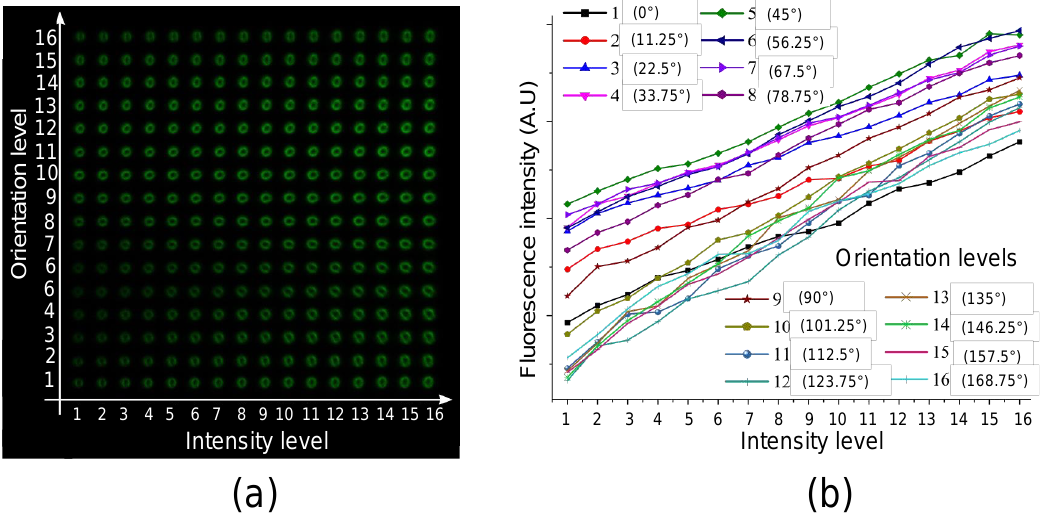
Figure 2. Fabricated fluorescence calibration matrix. ( a ) Confocal image of all basic storage units composed by 16 intensity levels and 16 orientation levels. ( b ) Measured fluorescence intensity versus incident DLW intensity for the 5D decoding process.